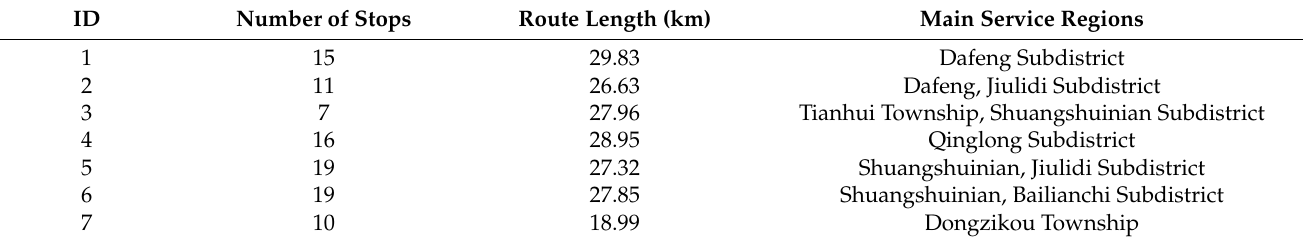
Figure 8. Generated shuttle service network.